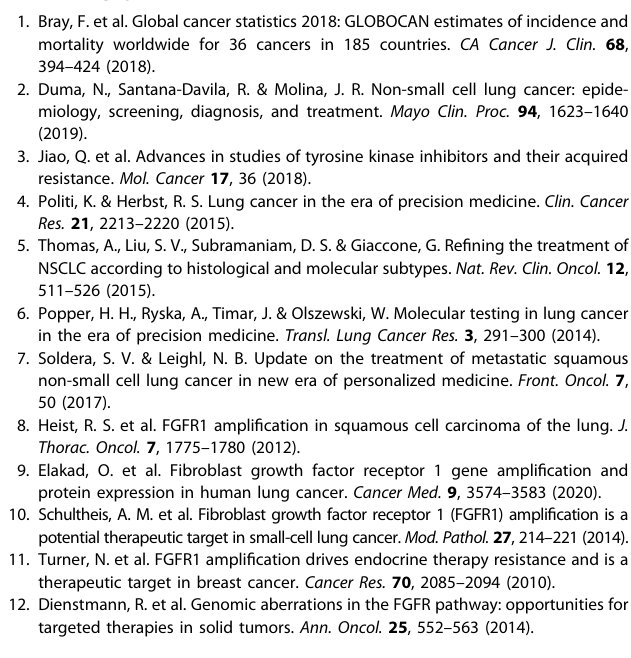
Fig. 5 CD44/PAK1 overexpression and phosphorylation promotes FGFR1 inhibition resistance through AKT activation. a Real-time PCR to determine mRNA levels of CD44 and PAK1 in resistant cells. b Western blot analysis comparing levels of CD44, PAK1 and AKT among sensitive and resistant cells. c Western blot analysis shows the effect of CD44 knockdown among sensitive and resistant cells. d , e Effect of CD44 knockdown on PAK and AKT expression and activation in ( d ) H520 and ( e ) H1581-C9R cell lines. f Real-time PCR to determine mRNA levels